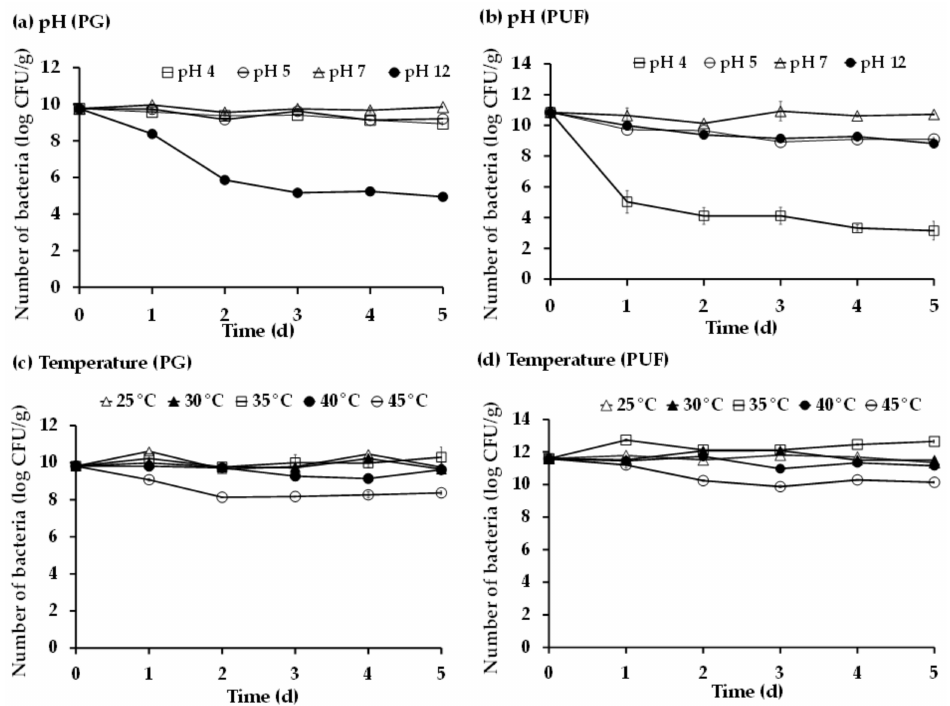
Figure 3. Numbers of P. versutus CM1 on PG and PUF under different ( a , b ) pH values and ( c , d )